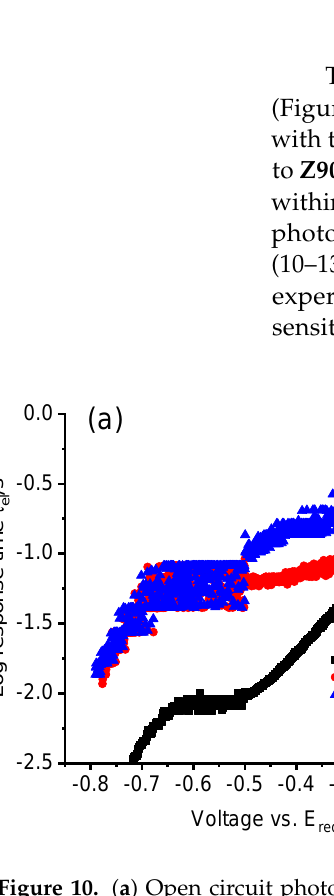
Figure 10. ( a ) Open circuit photovoltage decay of Z907 (black), 3 (red), and 4 (blue) sensitized solar cells; ( b ) –Z” vs. frequency plot of the same cells held at open circuit voltage.